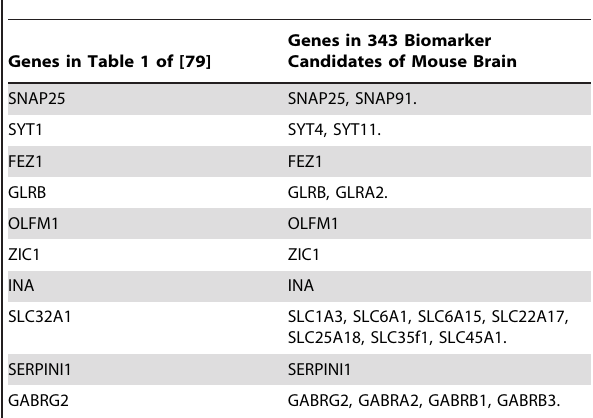
Table 7. Ten of 20 proposed human brain biomarker genes by [79] have the same or related matches among 343 biomarker candidate genes for mouse brain in our study.